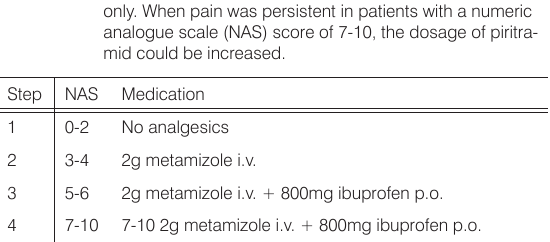
Table 1. Table for the administration of analgesia in the post anaesthesia care unit. Analgesics were given on demand only. When pain was persistent in patients with a numeric analogue scale (NAS) score of 7-10, the dosage of piritra- mid could be